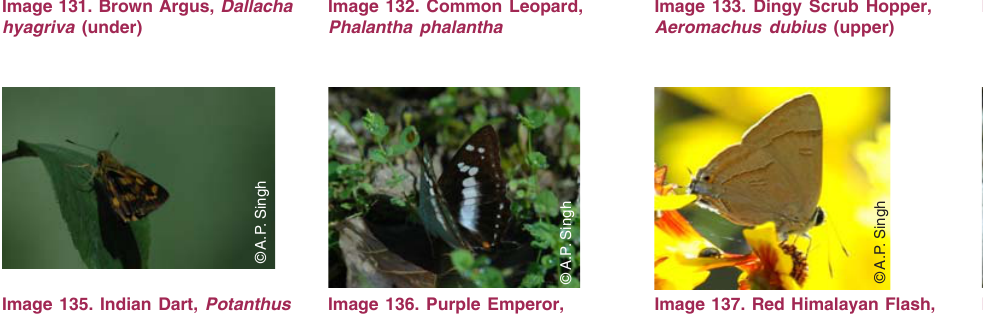
Image 135. Indian Dart, Potanthus pseudomaesa clio (upper)